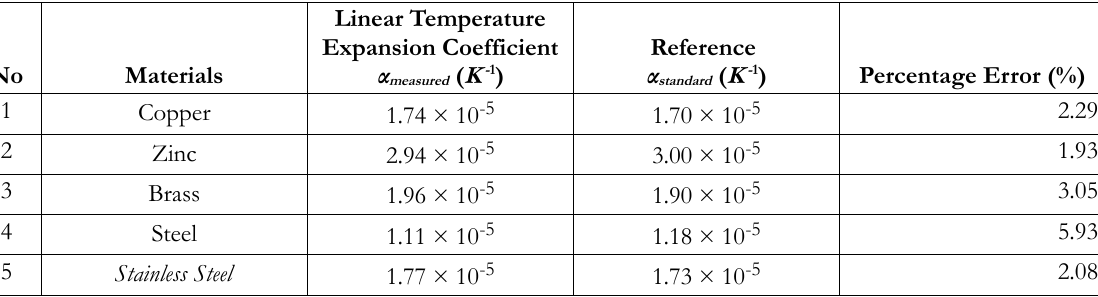
Table 3. Experiment result of linear temperature expansion coefficient based on equipment design in Figure